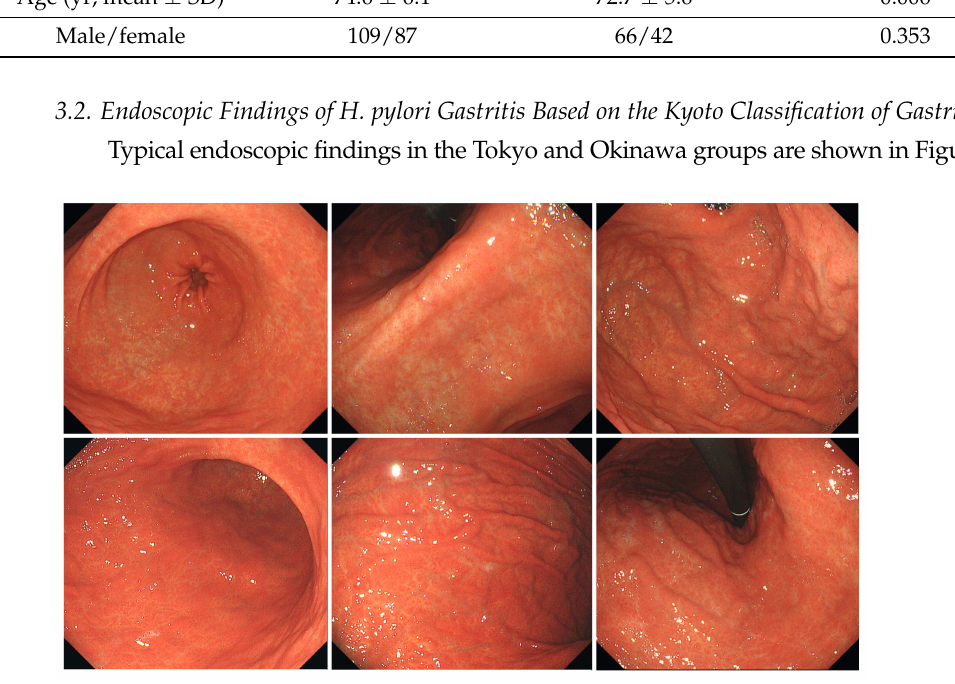
Figure 2. Typical endoscopic images of H. pylori -infected gastric mucosa in the Tokyo group. The patient is a 75-year-old woman. O-1 atrophy is observed, with diffuse redness, spotty redness, and mucosal swelling. Overall, it has a reddish tint.